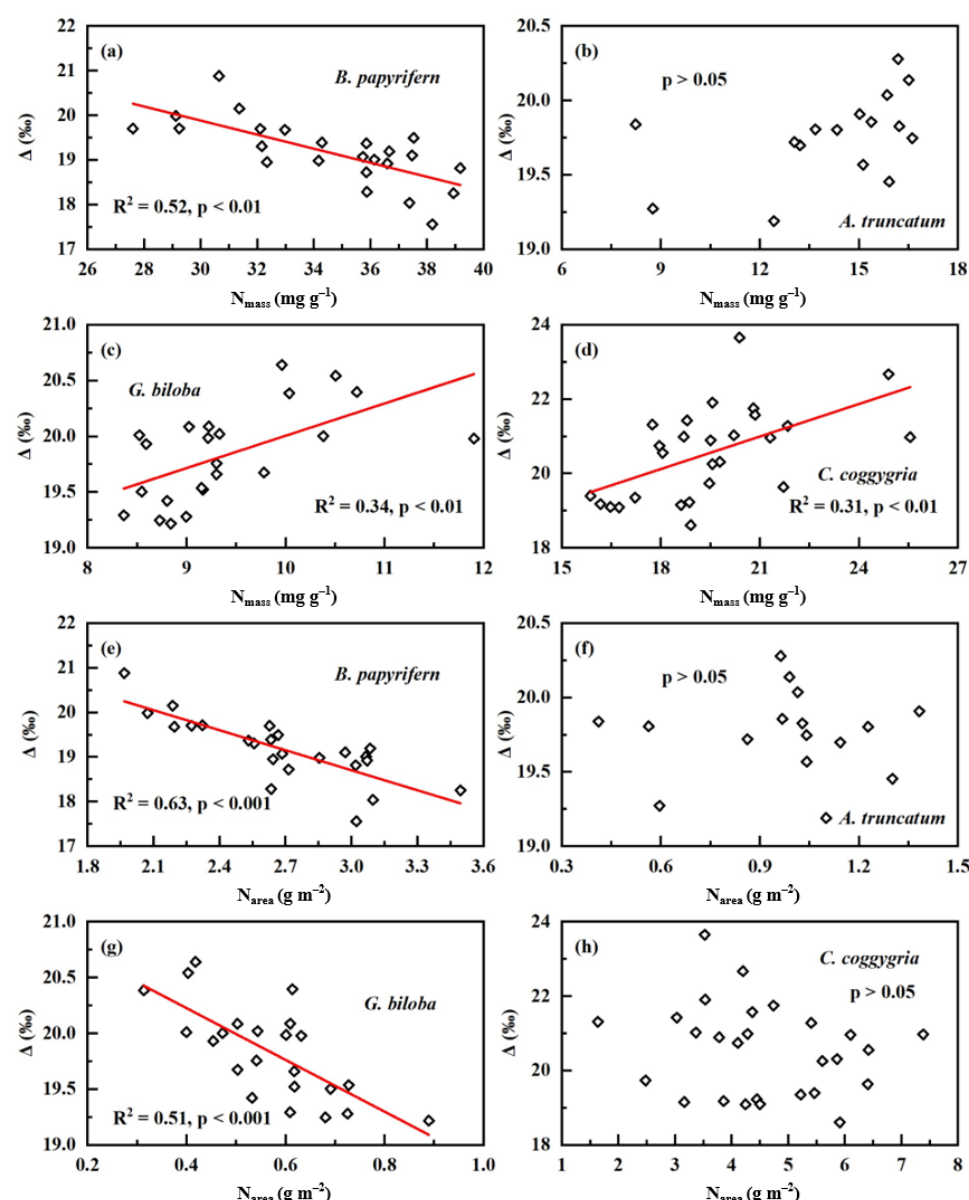
Figure 2. Relationships between leaf N and carbon isotopic discrimination ( ∆ ) at the population level for plants derived from the second sampling campaign: ( a – d ) N mass vs. ∆ ; and ( e – h ) N area vs. ∆. At the plant individual level, only Syringa oblate ( S. oblate ) showed a positive correla- tion between N mass and ∆ (R 2 = 0.26, p < 0.05, Figure 3a), and only Viburnum rhytidophyllum ( V. rhytidophyllum ) showed a negative correlation between N mass and ∆ (R 2 = 0.25, p < 0.05, Figure 3e), while with the other four species, N mass was not related to ∆ ( p > 0.05 for all; Figure 3b,c,d,f). For Viburnum sargentii ( V. sargentii ), V. rhytidophyllum and Clerodendrum trichotomum ( C. trichotomum ), there were significantly negative correlations between N area and ∆ (R 2 = 0.32, p < 0.05 for V. sargentii , R 2 = 0.49, p < 0.01 for V. rhytidophyllum , and R 2 = 0.23, p < 0.05 for C. trichotomum , Figure 3j,k,l), while none of the other three species had that correlation ( p > 0.05 for all species, Figure 3g,h,i).